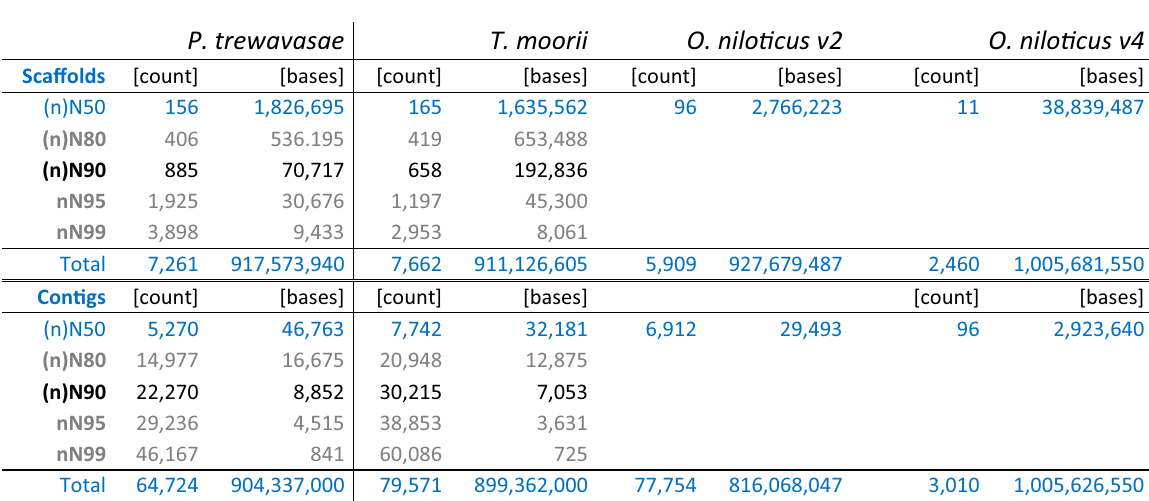
Table 1. Assembly contiguity and size statistics: The assembled genomes consist of 917.57 and 911.13 Mbp for P. trewavasae and T. moorii , respectively. Count and number of bases for scaffolds and contigs are reported. Scaffolds were broken to contigs at stretches of Ns of length ≥ 10. Statistics on O. niloticus were obtained from NCBI and extended as necessary (in blue); technology-wise version 2 is comparable, version 4 is based on high- coverage PacBio and optical mapping